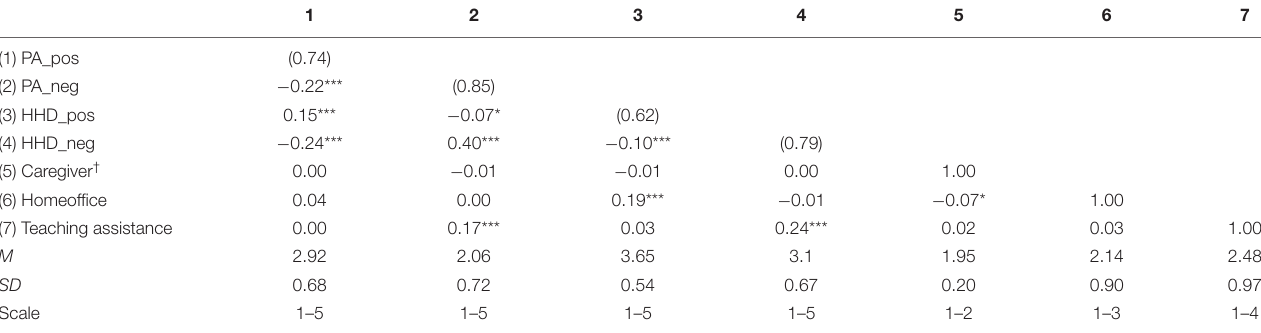
TABLE 4 | Zero-order correlations, Cronbach’s alphas, means, and standard deviations for main variables in this